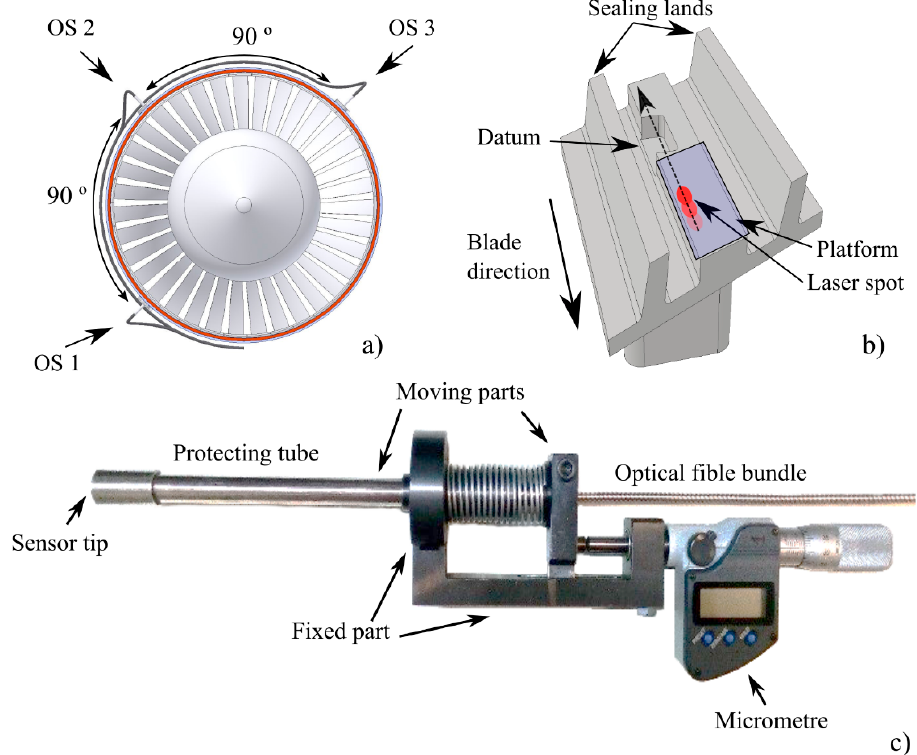
Figure 3. ( a ) Location of OS 1, OS 2, and OS 3 in the turbine casing. ( b ) Detail of a typical blade tip. ( c ) Side view of the tool used to locate precisely each sensor head with respect to the blade tips.